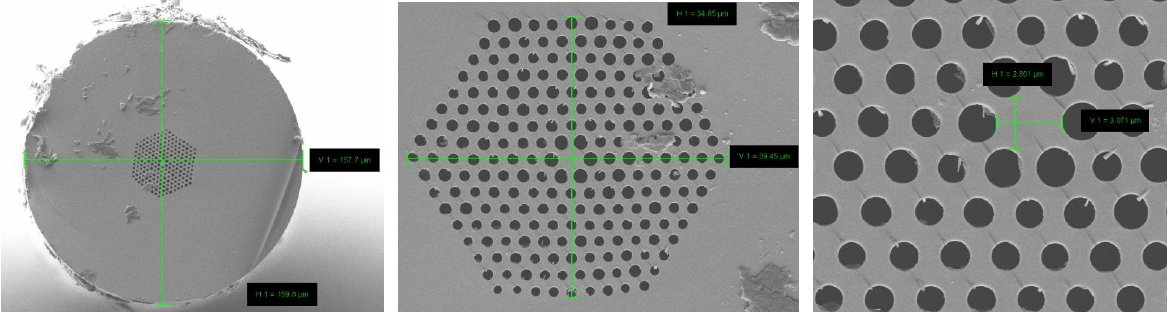
Figure 2. SEM images of single mode photonic crystal fiber made of lead-bismuth-gallate glass. Recorded dimensions of the fiber structure (horizontal × vertical): out fiber dimension 157.7×159.8 µm; photonic cladding 34.85×39.45 µm; fiber core 2.361 × 3.071 µm.